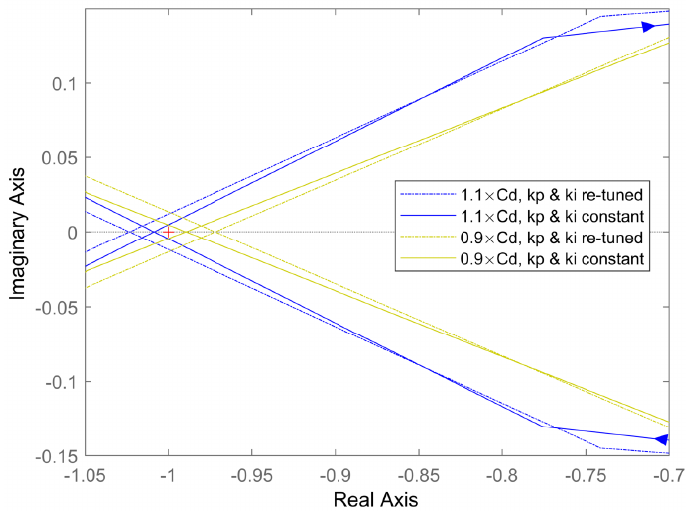
Figure 22. Nyquist plot for the eigenvalue λ 1 . Small variation of DC-link